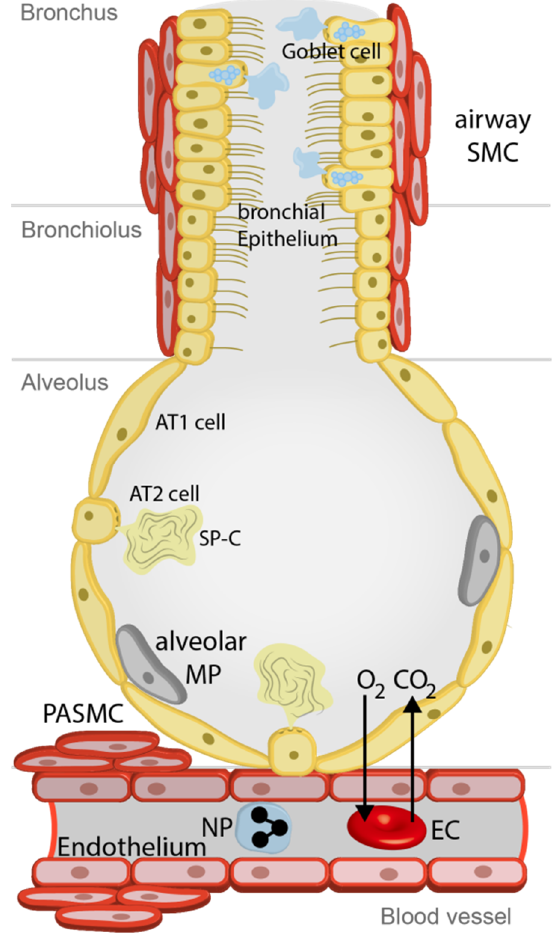
Figure 1. Cells involved in physiological functions of airways and lungs. See text for more details. Airway SMC, airway smooth muscle cells; Alveolar MP, alveolar macrophages; AT1 cells, alveolar type 1 cells; AT2 cells, alveolar type 2 cells; CO 2 , carbon dioxide; EC, erythro-cyte; O 2 , oxygen; NP, neutrophil; PASMC, precapillary arterial smooth muscle cells, SP-C, surfactant protein-C.